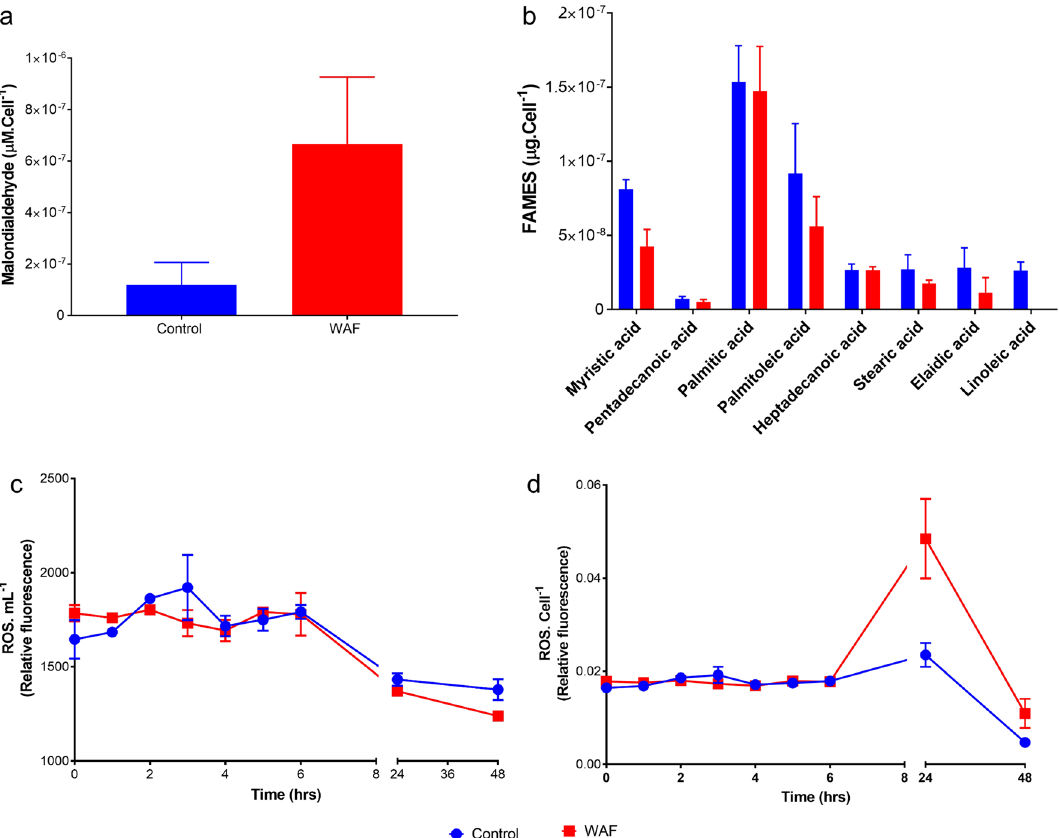
Figure 3. Biochemical response of T. pseudonana . ( a ) average malondialdehyde per cell (MDA) after 48 h of incubation, ( b ) average FAME composition per cell of T. pseudonana after 48 h of incubation, ( c ) average total reactive oxygen species per mL (ROS.mL −1 ) through time during the 48 h of incubation, and ( d ) average total reactive oxygen species to cell concentration ratio (ROS.cell −1 ) through time during the 48 h of incubation in T. pseudonana (± standard deviation) under Control and WAF treatments (n =